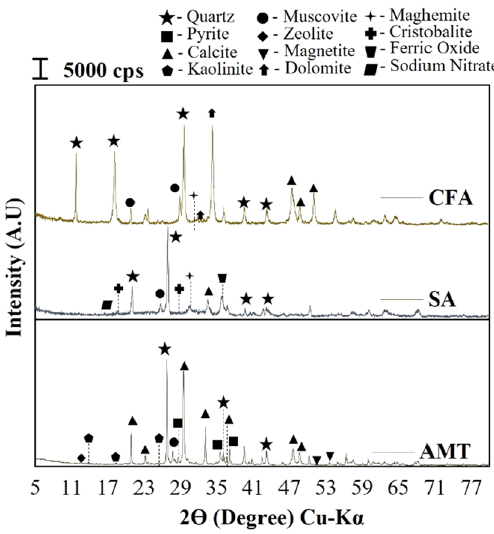
Figure 4. XRD pattern of the industrial waste